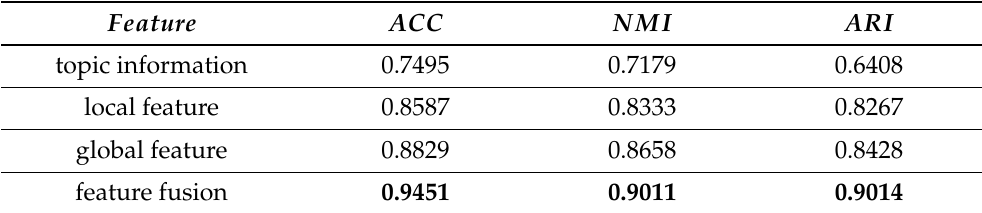
Table 6. Clustering results with different